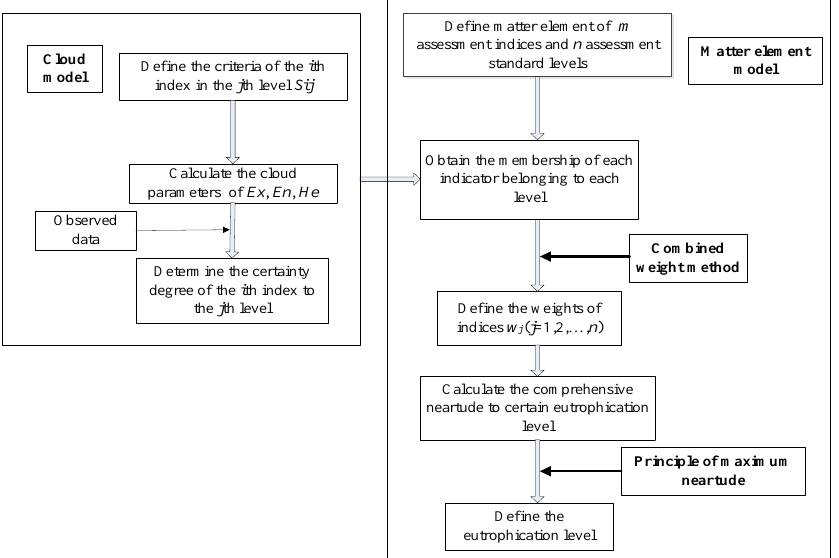
Figure 2. Flowchart of the cloud matter element (CME) model.